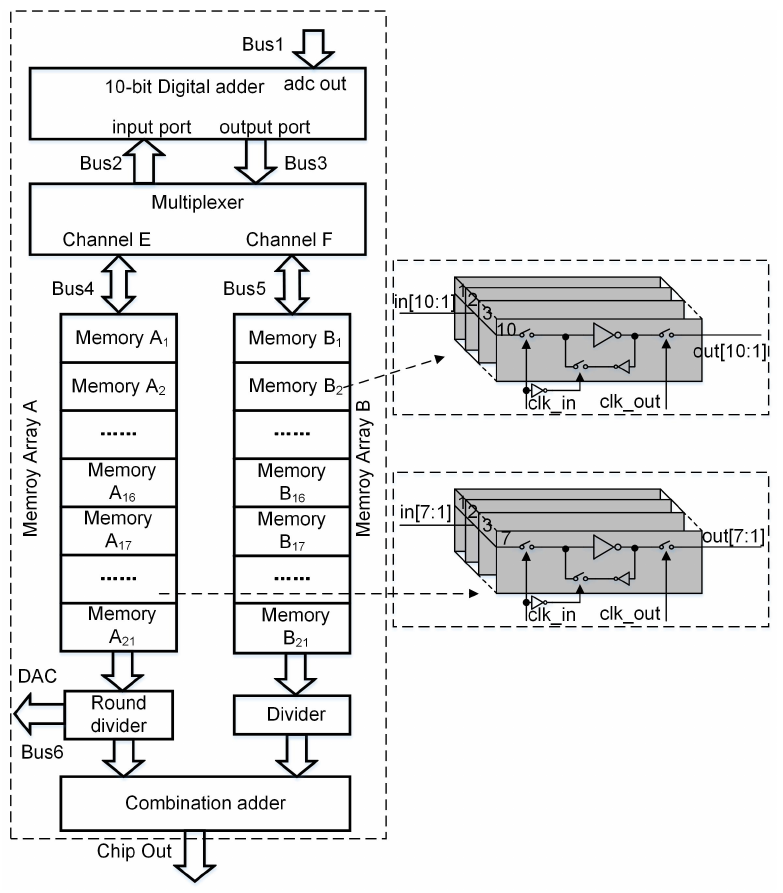
Figure 12. Block diagram of the digital